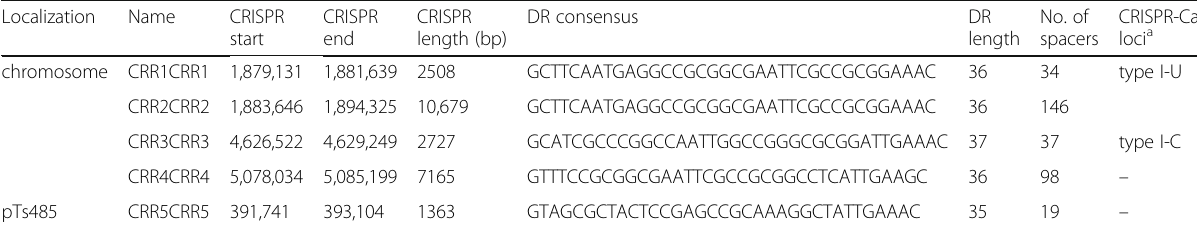
Table 6 CRISPR-Cas loci detected in “ T. syntrophicum ” sp. nov. strain Cad16 T